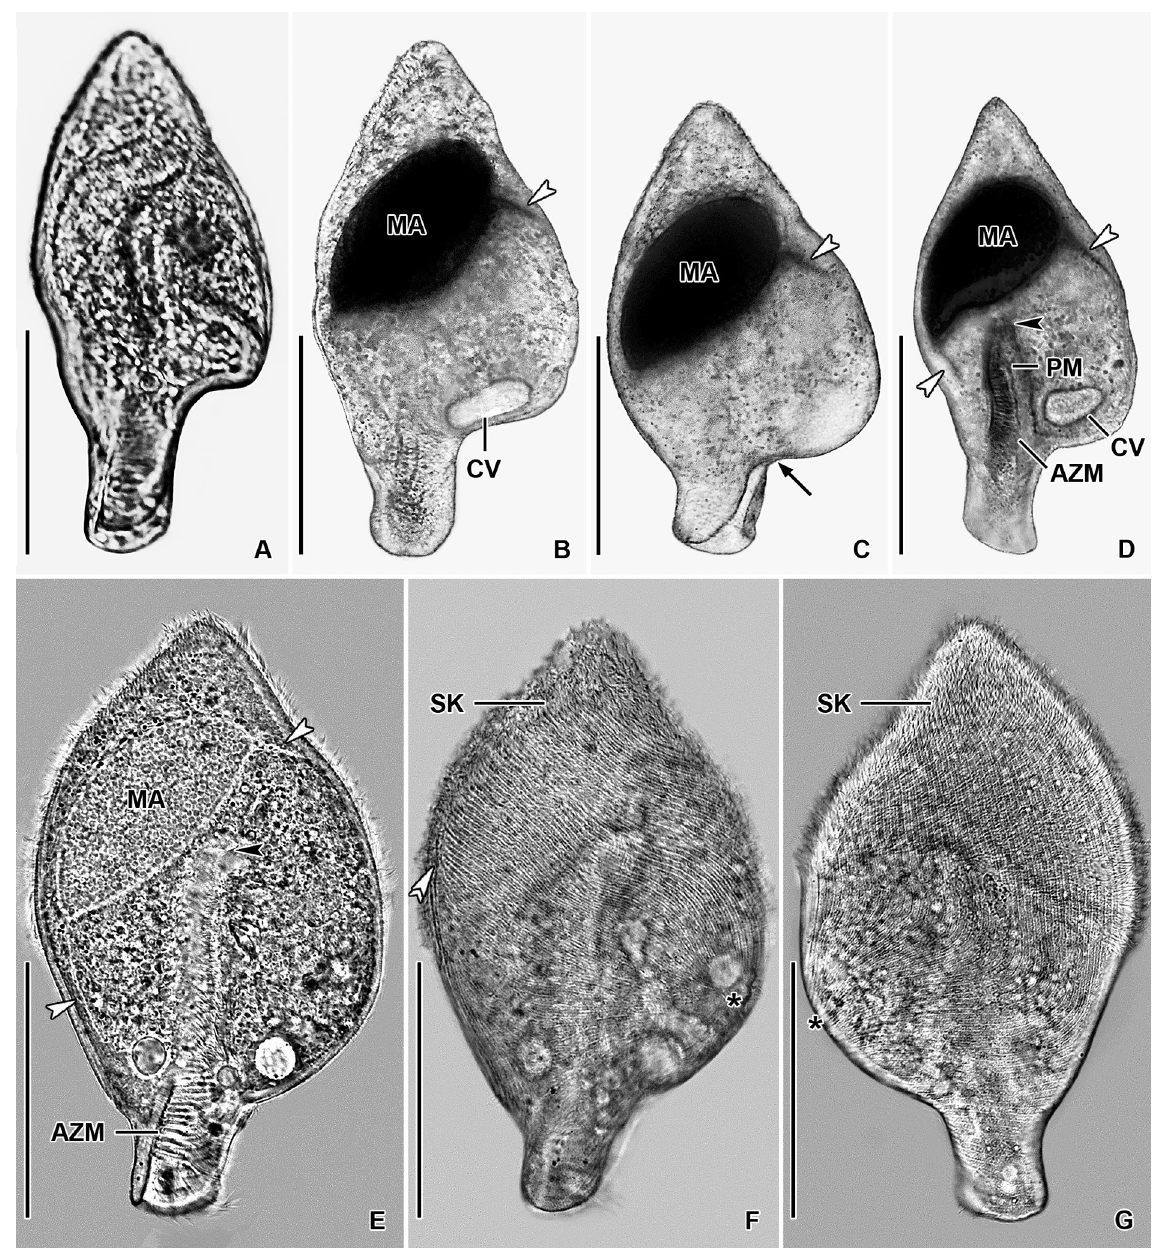
Fig. 8. Clevelandella panesthiae (Kidder, 1937). Vietnamese specimens (a, E–G) isolated from Panesthia angustipennis cognata Bey-Bienko, 1969 and Thai I specimens (B–D) isolated from Panesthia angustipennis angustipennis (Illiger, 1801) from life (a, E–G) and after protargol impregnation (B–D). A–D . Ventral view of specimens with well-preserved body shape. Arrow marks the proximal end of the peristomial opening, black arrowheads denote the proximal end of the adoral zone of membranelles, white arrowheads mark the karyophore fibers attaching to the left and right body margins. E . Ventral view, showing the general body organization. F–G . Ciliary pattern of ventral and dorsal sides. Asterisks mark the position of the ciliary whorl (posterior suture), white double arrowhead denotes the right suture. Scale bars = 50